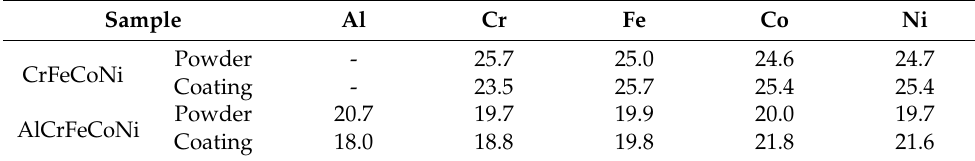
Table 1. Chemical composition of atomized powder and HS-LMD coating in at.%, measured using EDS.